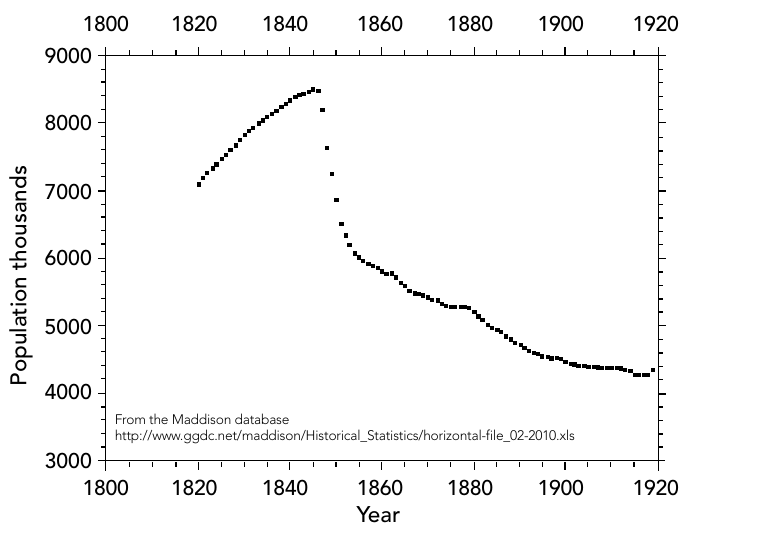
Fig. 5 – Irish population data before and after the great famine of